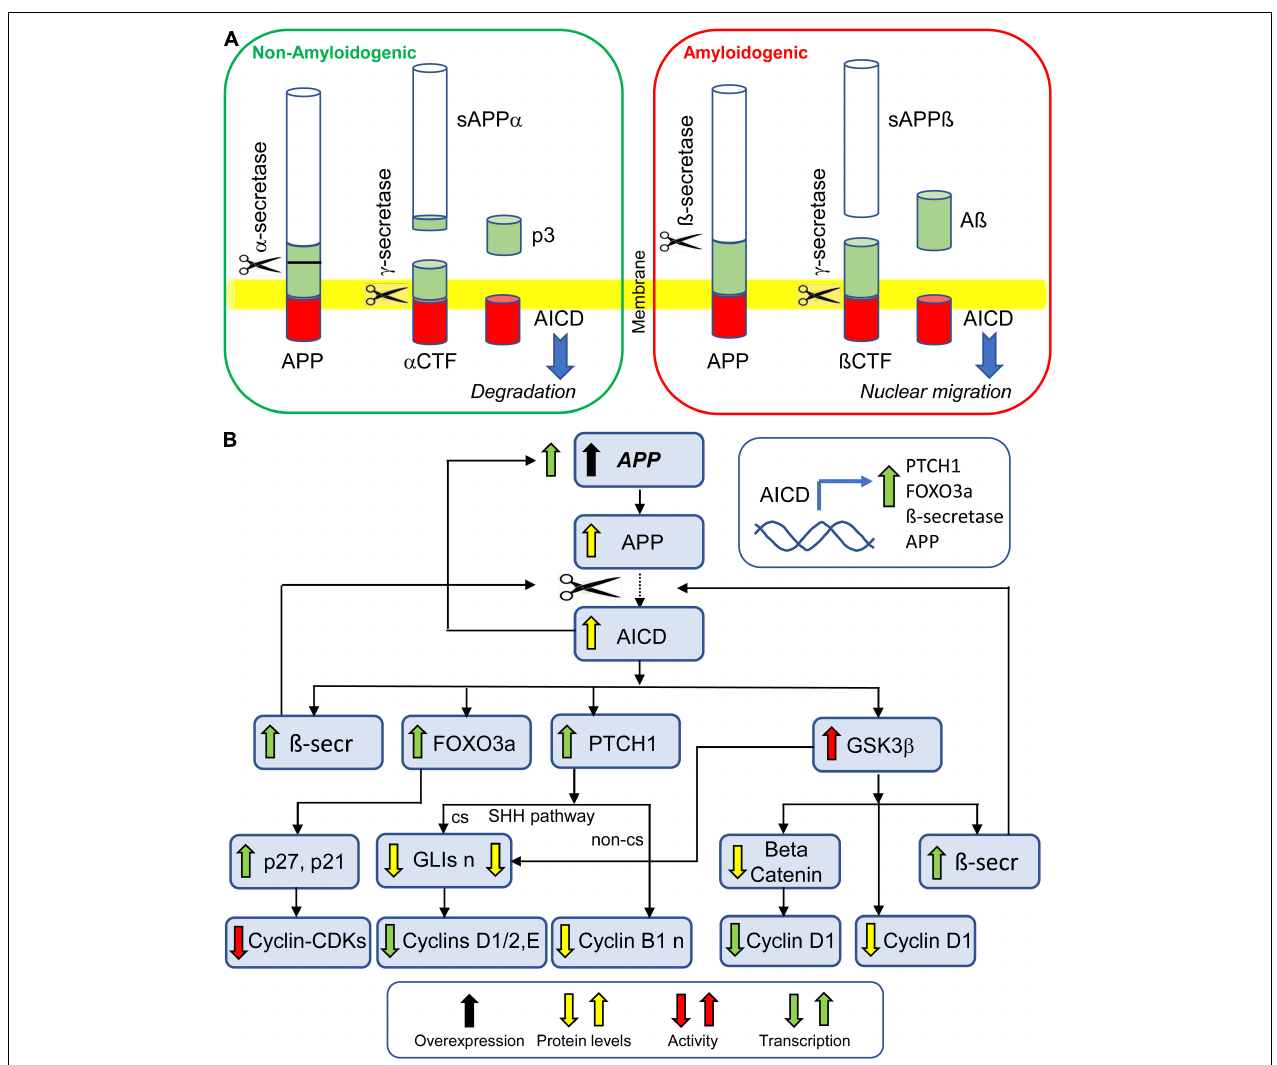
FIGURE 5 | Effect of APP overexpression on NPC proliferation. (A) Proteolytic processing of APP by non-amyloidogenic pathway and amyloidogenic pathway. Both pathways give origin to AICD. While AICD produced by non-amyloidogenic processing undergoes degradation, AICD produced by amyloidogenic processing translocates to the nucleus and promotes transcription of various genes (inset in B ). (B) APP overexpression leads to excessive levels of AICD. The AICD promoted transcription of PTCH1 leads to reduced transcription of cyclin D1 (through the SHH canonical pathway) and reduced levels of cyclin B1 (through the SHH non-canonical pathway). The AICD promoted transcription of FOXO3a promotes the transcription of p27 and p21, thereby inhibiting the activity of cyclin-CDKs. The AICD promoted transcription of ß-secretase enhances the amyloidogenic cleavage of APP. The AICD-mediated increase in GSK3ß activity causes a beta-catenin-mediated reduction in cyclin D1 transcription, a reduction in cyclin D1 levels, due to its degradation, and an increase in the transcription of ß-secretase, thereby enhancing the amyloidogenic cleavage of APP. Abbreviations: AICD, intracellular C-terminal domain; APP, amyloid beta precursor protein; α CTF, α carbossi terminal fragment; ßCTF, ßcarbossi terminal fragment; ß-secr, ß-secretase; cs, canonical signaling; n, nuclear; non-cs, non-canonical signaling; sAPP α , soluble APP α ; and sAPPß, soluble